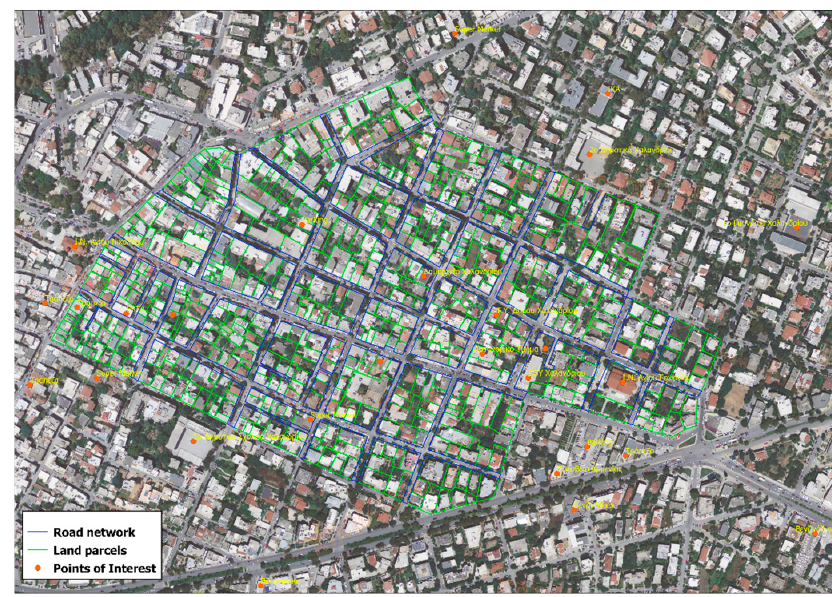
Figure 22. Initial advanced crowdsourced cadastral basemap.